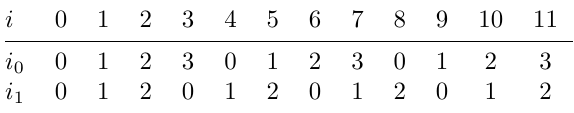
Table 4: Good’s permutation for size